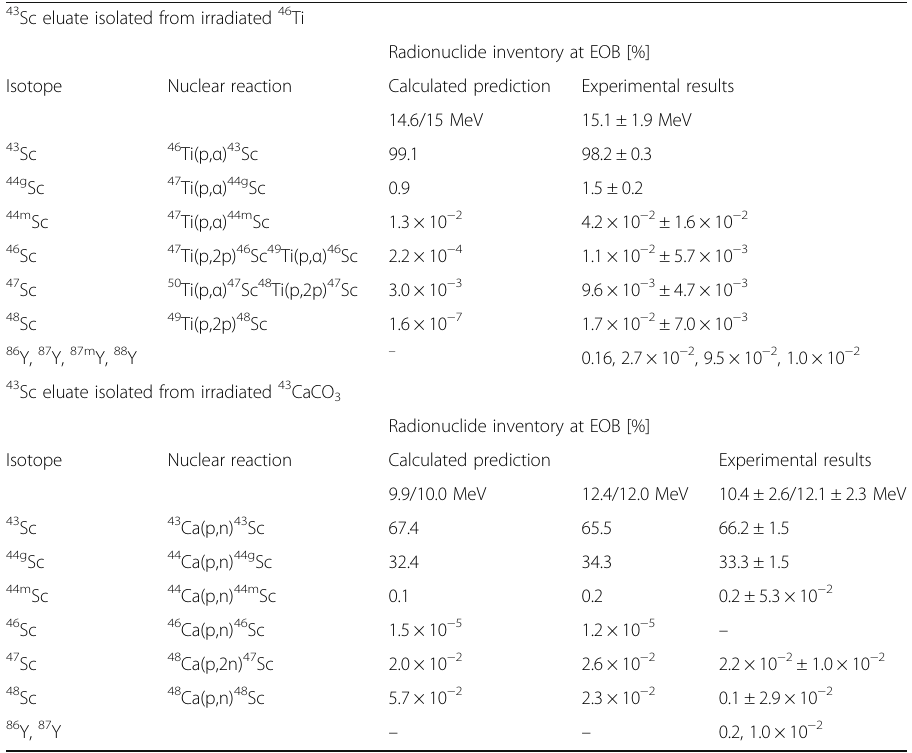
Table 3 The radionuclide inventory of the 43 Sc eluate, isolated from irradiated 46 Ti and 43 CaCO 3 targets is shown, together with the calculated values at EOB. Cross section data for the nuclear reactions 46 Ti(p, α ) 43 Sc, 43 Ca(p,n) 43 Sc and 44 Ca(p,n) 44 Sc were taken from Carzaniga et al. (Carzaniga et al. 2017), while the data for all other nuclear reactions was retrieved from the TENDL 2015 database (Koning et al. 2015)